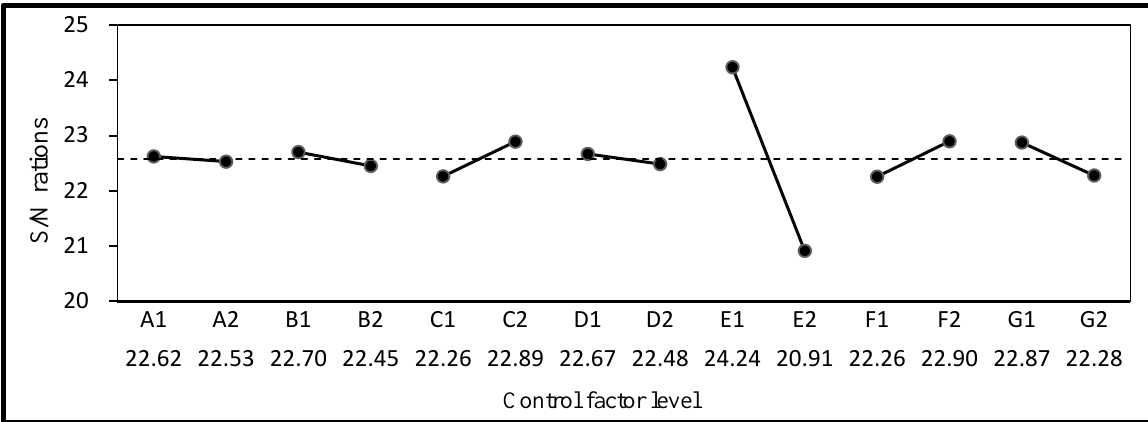
Figure 4. S/N ratio response graph for water absorption.